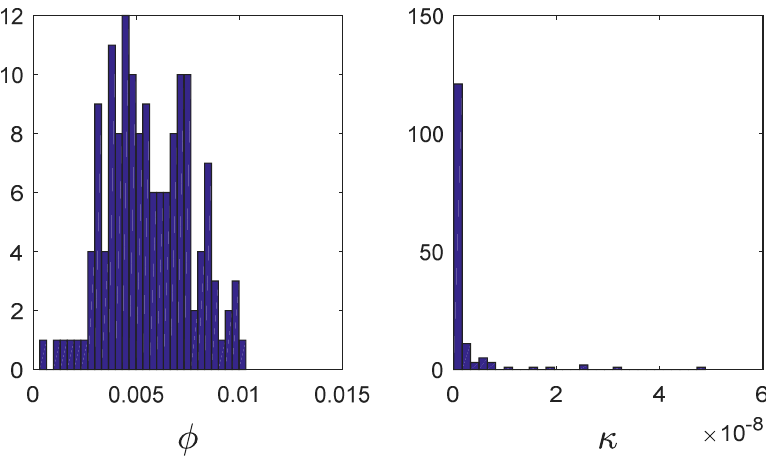
Figure 28. Porosity & permeability distributions for Figure 24 synthetic normal probability plot Borrowdale Volcanics Group wellbore recharge data. BVG field-scale permeability distribution minimum permeability κ ~ 3 × 10 − 20 m 2 for crustal volumes with no evidence of passing fluid through active fracture structures versus minimum BVG permeability κ ~ 3 × 10 − 18 m 2 for crustal volumes with evidence of passing fluid through active fracture structures.